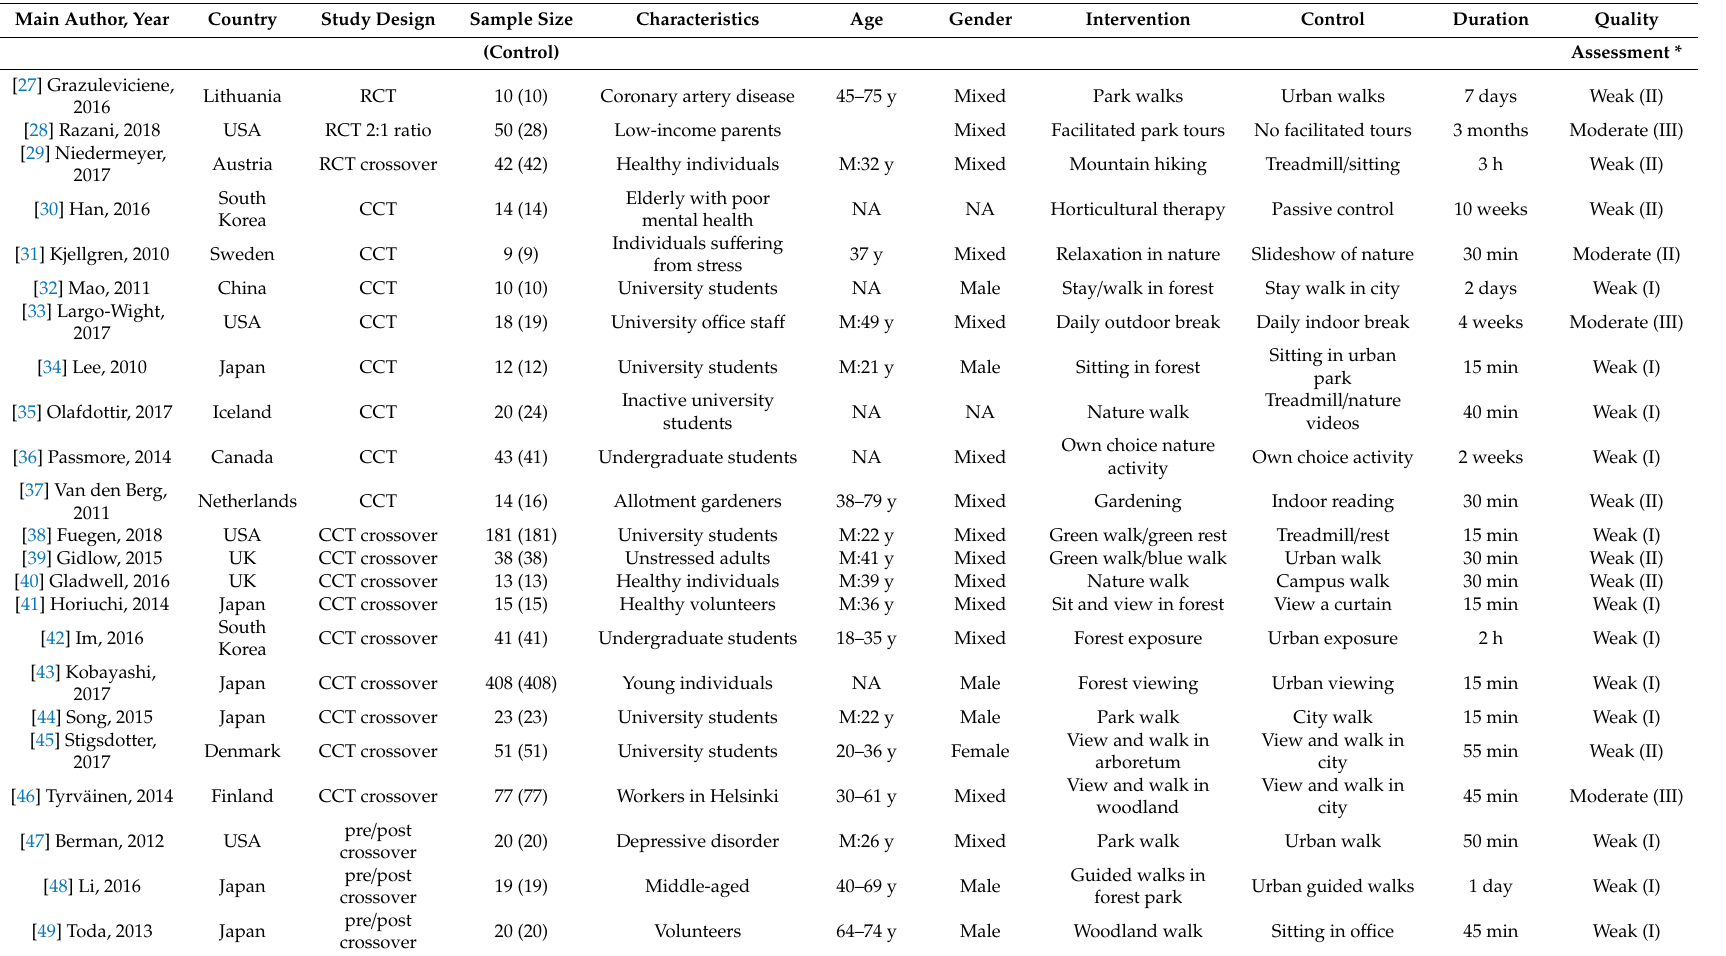
Table 2. Characteristics of included